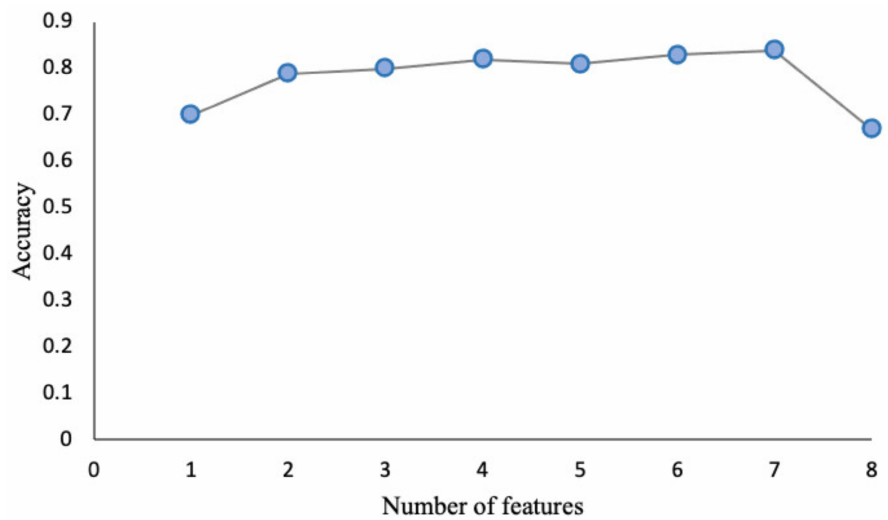
Figure 5. Sequential backward selection (SBS). To improve computational efficiency and reduce generalization error, the sequential backward selection algorithm aims to reduce the dimensionality of the initial feature subspace from N to K features with minimal model performance loss. To obtain the list of K features, sequentially remove features from a given features list of N features. By including seven characteristics of the dataset, excluding cadence, we maximized the performance of the algorithm, which, in our case, turned out to be KNN.